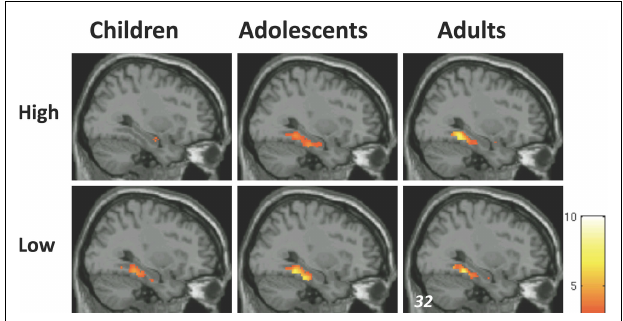
FIGURE 3 | MTL activations associated with successful memory formation (R > F) for children, adolescents, and young adults, for high- complexity scenes (top), and low- complexity scenes (bottom), scenes. Activation maps are overlaid on standard T1 image (for display purposes, p < 0.005, uncorrected, T value scale presented on the right). Children, n = 16, 8 male, mean age 10.7, range 8–12 years of age; adolescents, n = 16, 8 male, mean age 15.9, range 13–17 years of age; adults, n = 14, 7 male, mean age 21.3, range 19–24 years of age. This three-group stratifi cation is illustrative, but statistical analyses were conducted with age as a